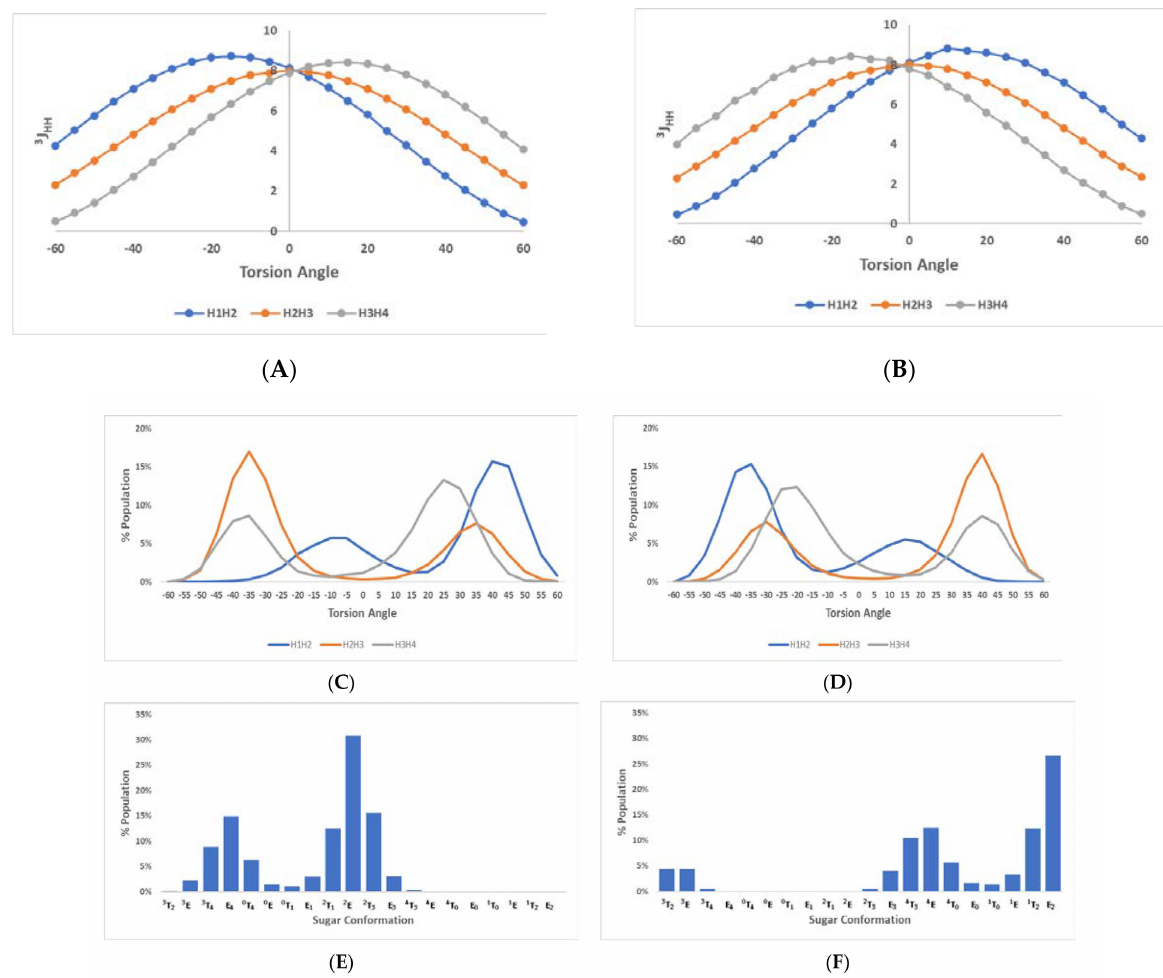
Figure 6. ( A , B ) Theoretical 3 J HH coupling constants distribution; ( C , D ) distribution of 3 J HH coupling after MD; ( E , F ) distri- bution of furanose conformers of β - D - and β - L - C -lyxofuranoside residues of Ochraceopyronide ( 1 ),